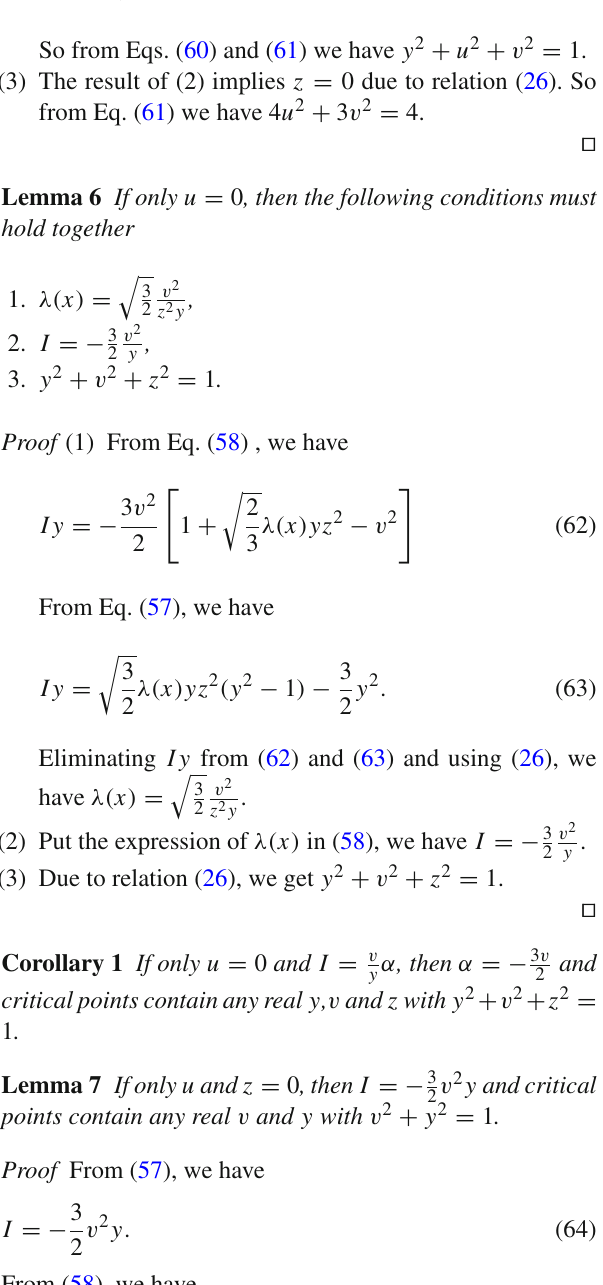
Table 3 Stability of the vector field on every coordinate plane for the critical point C 4 Coordinate